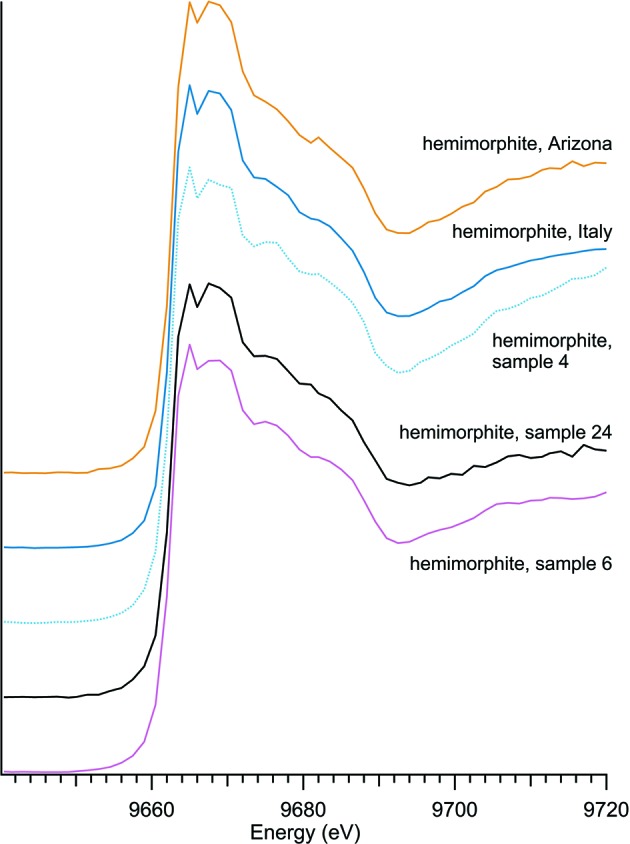
Comparison of hemimorphite minerals.